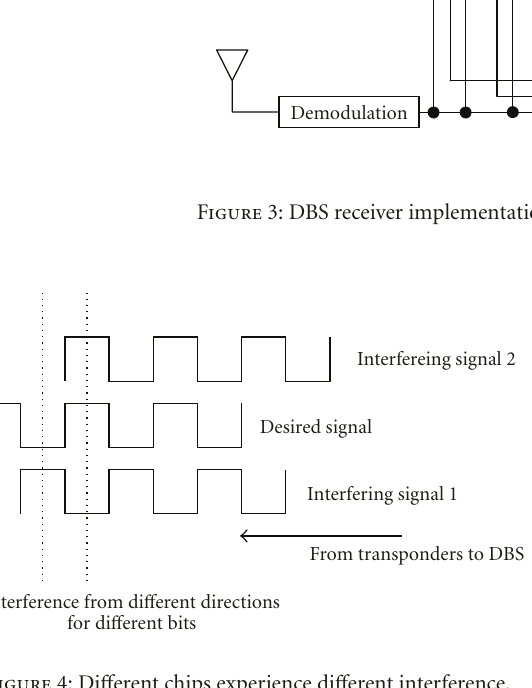
Figure 4: Di ff erent chips experience di ff erent